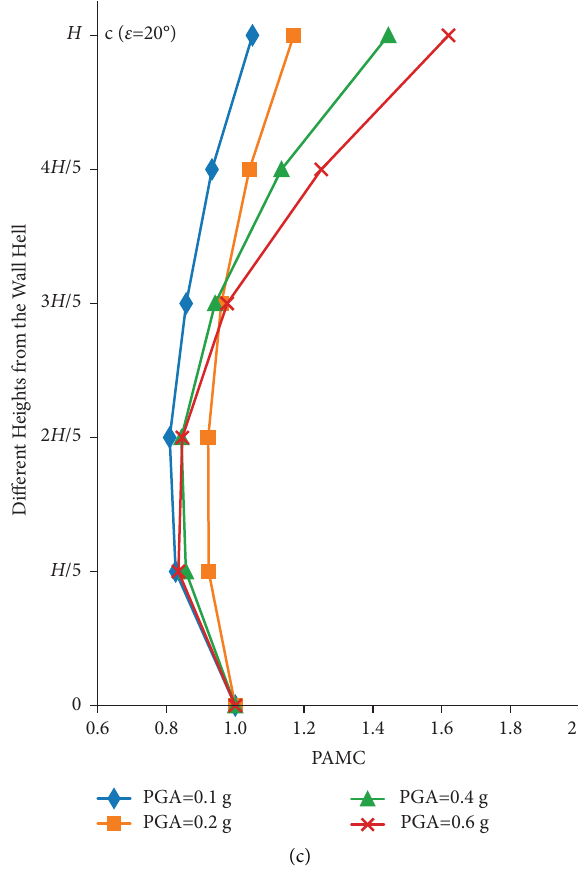
Figure 7: Average PAMC along wall height. (a) Reclined wall. (b) Vertical wall. (c) Inclined